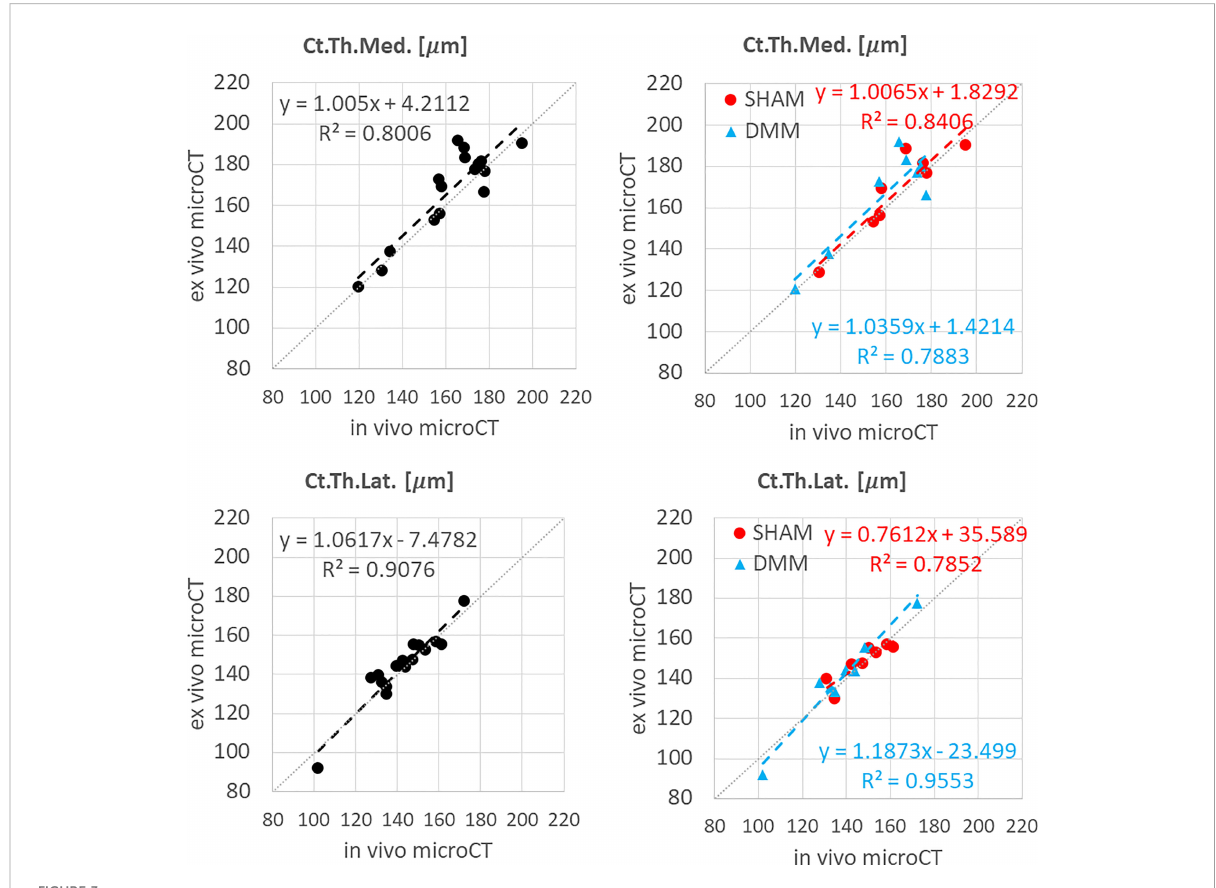
FIGURE 3 Regression analyses between in vivo and ex vivo measurements for cortical thickness (Ct.Th) at the medial and lateral